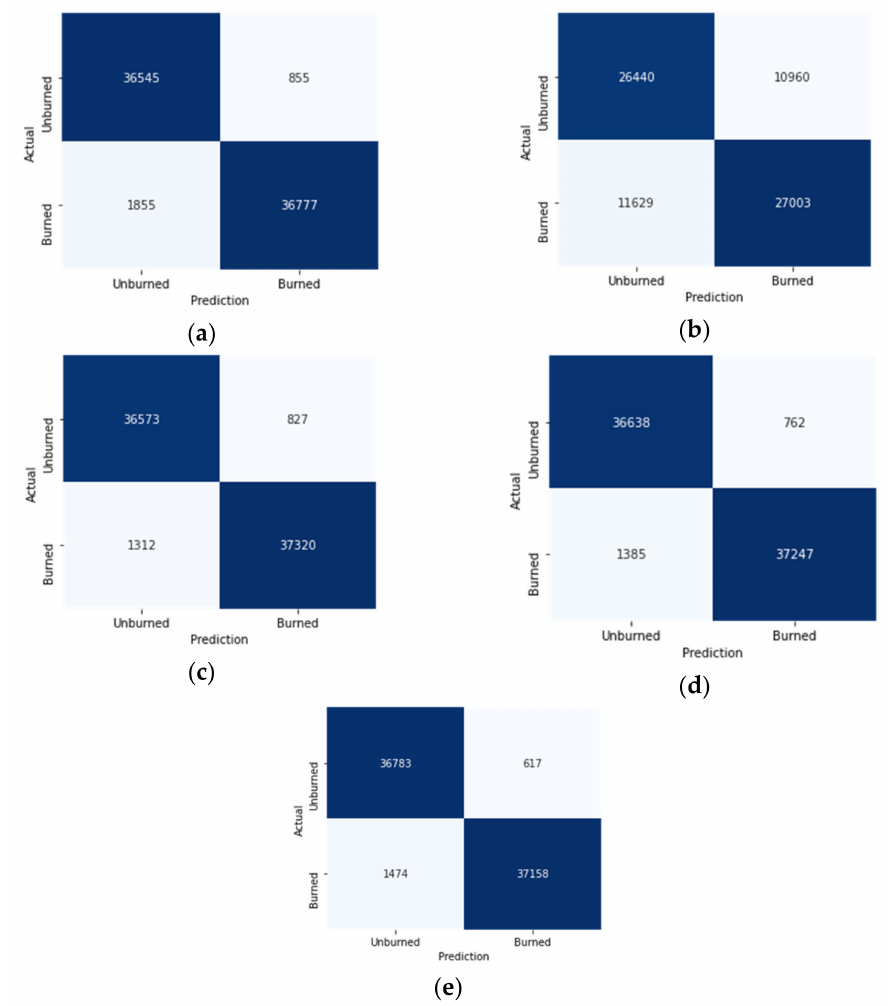
Figure 12. ( a – e ) Confusion matrix classification of the burned area using CNN-RF method for Schemes